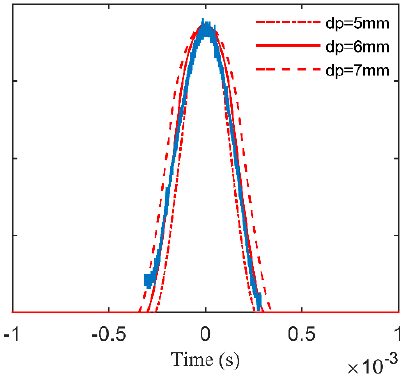
Figure 8. The simulation curves and the measured signal.